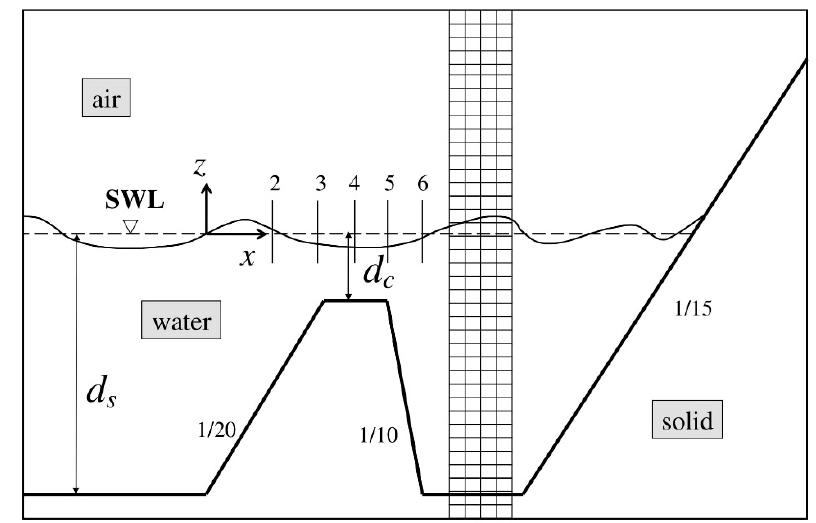
Figure 1. Sketch of the computational domain and part of the Cartesian grid, as well as definitions of parameters for the numerical simulation of wave propagation over a submerged impermeable trapezoidal bar [27]. Note that the axes are not to scale. The distance from the wavemaker to the seaward toe of the bar is 27 d S , while the distance from the leeward toe of the bar to the toe of the absorbing beach is 5 d S .